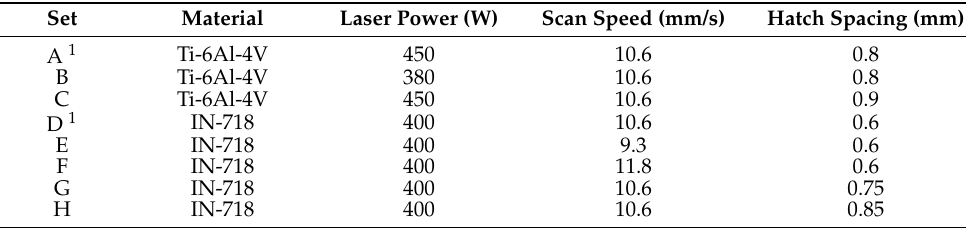
Table 1. Process parameter sets for DED-AM builds. Set Material